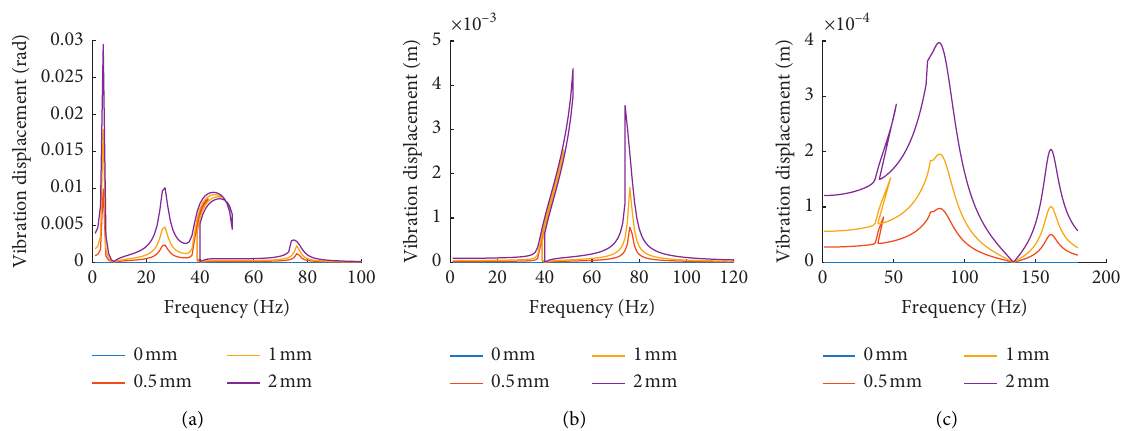
Figure 5: Frequency domain vibration signal of the work roll: (a) vibration acceleration in the torsional direction; (b) vibration acceleration in the vertical direction; (c) vibration acceleration in the horizontal direction.